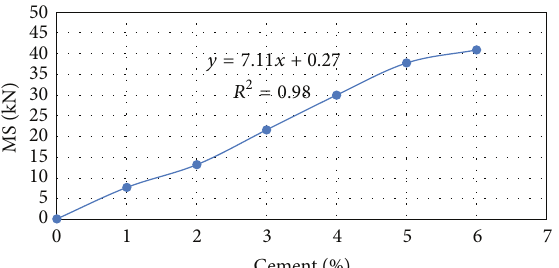
Figure 4: Influence of cement content on ITS of CTB.